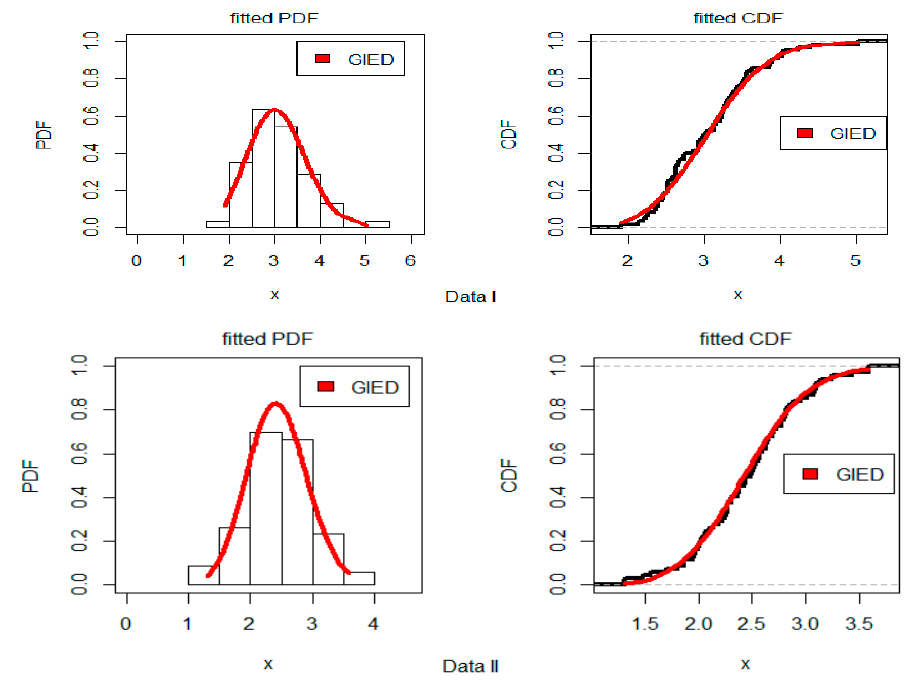
Figure 7. Estimated PDF and CDF plots using Data I and II for the GIED.